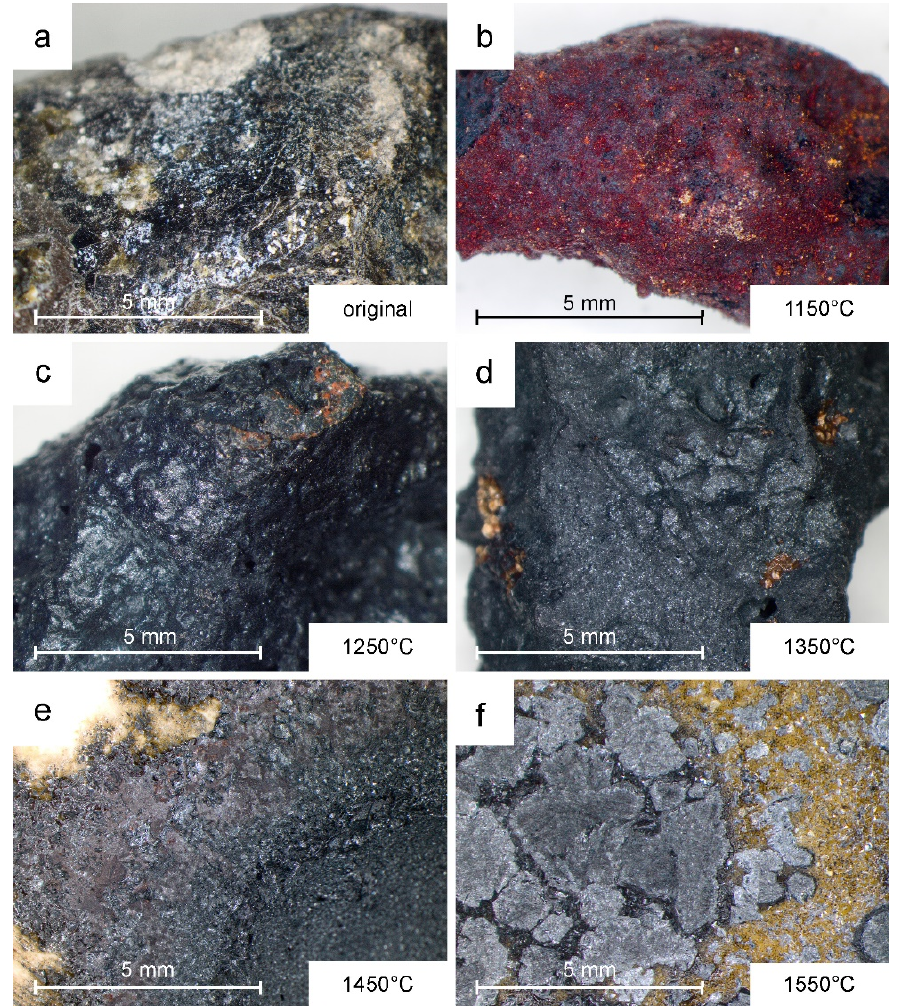
Figure 6. Macrophotographs of slag from Łosień before ( a ) and after heating experiments in temperatures of: ( b ) 1150 °C; ( c ) 1250 °C; ( d ) 1350 °C; ( e ) 1450 °C; ( f ) 1550